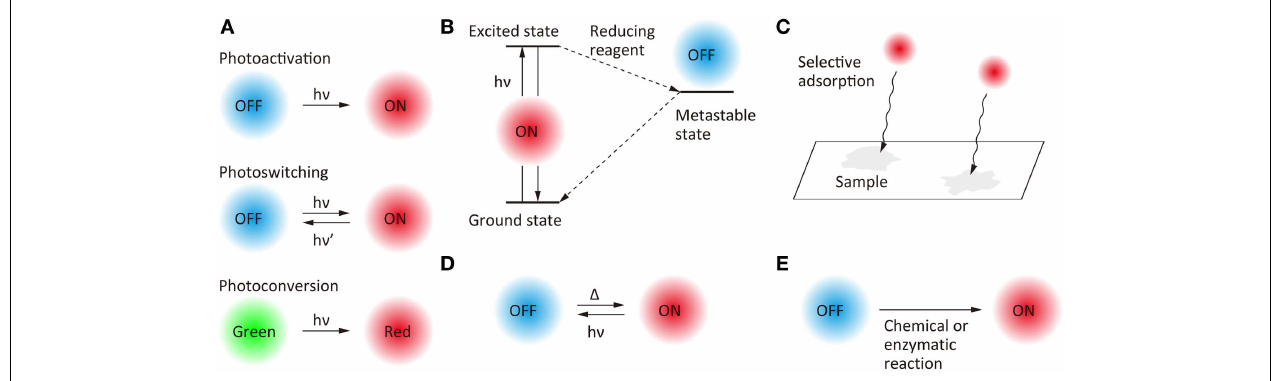
FIGURE 2 | Scheme of the switching of fluorescence states for super-resolution fluorescence localization microscopy. (A) Photo-induced switching, (B) photo-induced redox switching, (C) selective adsorption, (D) photo- and thermal-induced switching, and (E) chemical or enzymatic reaction-induced